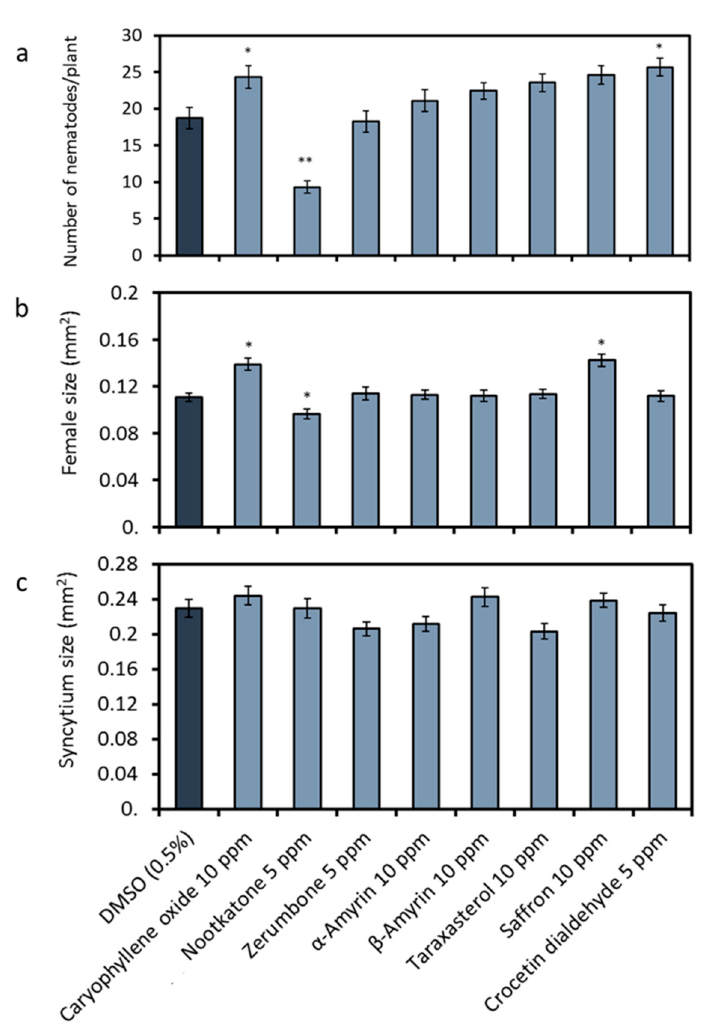
Figure 3. E ff ects of plant metabolites on Heterodera schachtii parasitism. Arabidopsis was grown on a medium complemented with plant terpenoids (Figure 1) or DMSO as the control and inoculated with H. schachtii J2s. Parameters representing the nematodes’ parasitic success were recorded: ( a ) Average number of total nematodes developed on an Arabidopsis Col-0 plant. ( b ) Average sizes of females at 13 days after inoculation (DAI). ( c ) Average sizes of syncytia at 13 DAI. Data are based on three independent experiments. Each bar represents the mean ± SE of n > 35. The asterisk marks indicate significant di ff erences to the control based on a t -test (* p < 0.05 and ** p < 0.01).